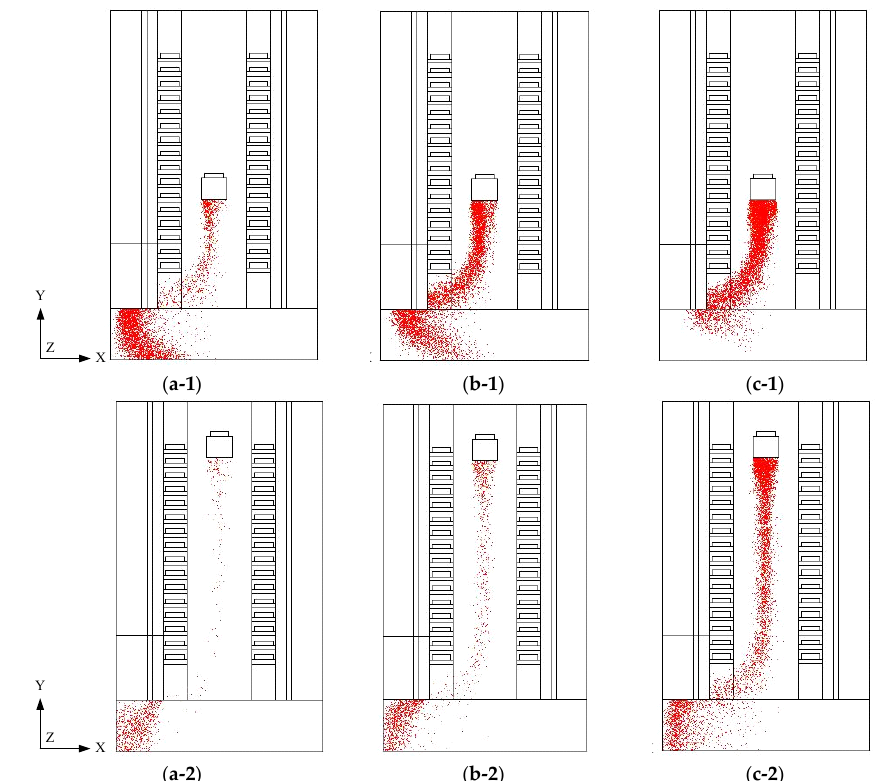
Figure 9. Evolution of the X-Y cross section particle distributions (at Z = 2.81 m) while a crane moves along the Y axis with a velocity of ( a ) 0.3 m/s; ( b ) 0.4 m/s; and ( c ) 0.6 m/s at different locations. Here, 1 and 2 of sub-figures stand for the different location of the Y axis.